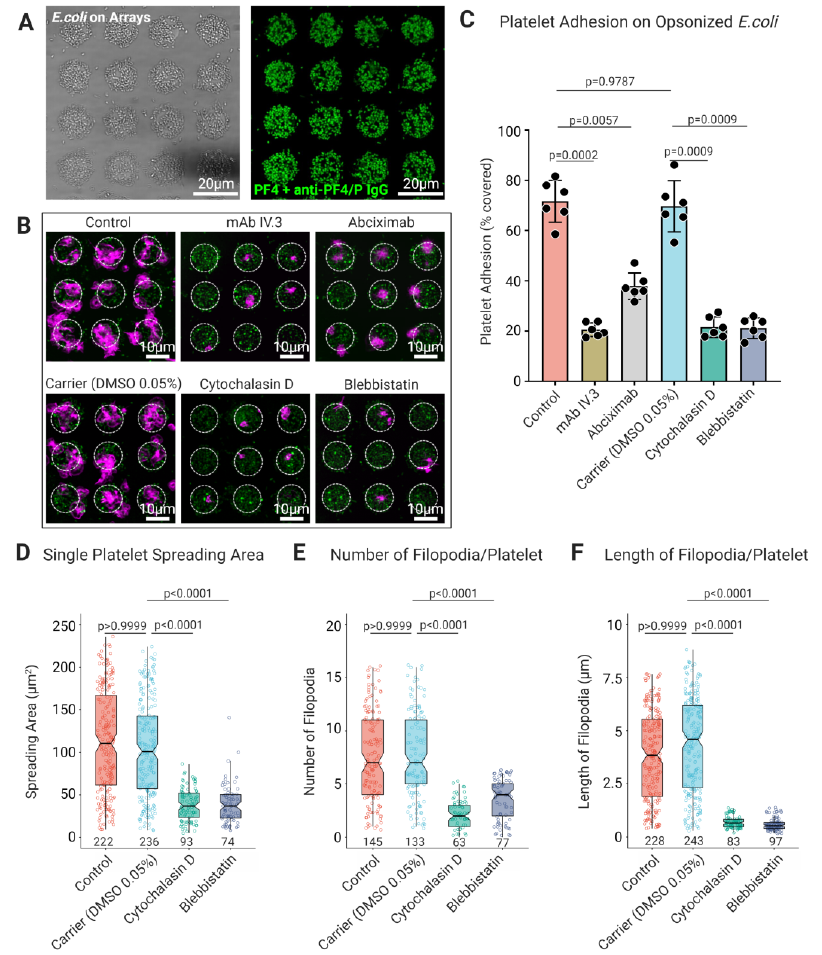
Figure 7. Platelets specifically recognize opsonized by PF4 + anti-PF4/P IgG via Fc γ RIIA using filopodial protrusions, while their adhesion and spreading are regulated by cytoskeletal rearrangement. ( A ) Light transmission and CLSM immunofluorescence micrographs of live E. coli KPM121 (Δ waaA ) opsonized with PF4 + anti-PF4/P IgG immobilized on micropattern arrays (detected using goat anti-human IgG Alexa 488 in green); ( B ) Representative CLSM images of platelet adhesion and ( C ) analysis of spreading area of single platelets pretreated with FcγRIIA blocking mAb IV.3 (4 µg/mL) , integrin αIIbβ3 blockin g antibody, cytochalasin D (25 µM), and blebbistatin (10 µM) shows significant reduction comparison with untreated platelets (control) and DMSO 0.05% (as carrier) on their spreading on E. coli KPM121 (Δ waaA ) opsonized with PF4 and anti-PF4/P IgG (platelet F-actin in magenta, patient-derived anti-PF4/P IgG detected using goat anti-human IgG Alexa 488 in green). Data represent mean ± SD from n = 6 donors, and statistical comparisons were performed using one- w ay ANOVA , followed by Tukey’s multiple comparisons test. Inhibition of platelet F-actin polymerization by cytochalasin D (25 µM) and myosin II ATPase inhibitor blebbistatin (10 µM) sig- nificantly reduces ( D ) spreading area, ( E ) number and ( F ) length of filopodia in single platelets in comparison with untreated platelets (control) and DMSO 0.05% (as carrier) on opsonized E. coli . Statistical comparisons were performed by one-way ANOVA on ranks (non -parametric), followed by Dunn’s multiple comparisons test. Boxplots extend from 10 to 90 percentiles, and p < 0.05 is sig- nificant. 4. Discussion In human health and disease, platelet FcγRIIA plays a vital role in the pathophysiol- ogy of diseases, such as HIT and VITT , where crosslinking of platelet FcγRIIA by anti -